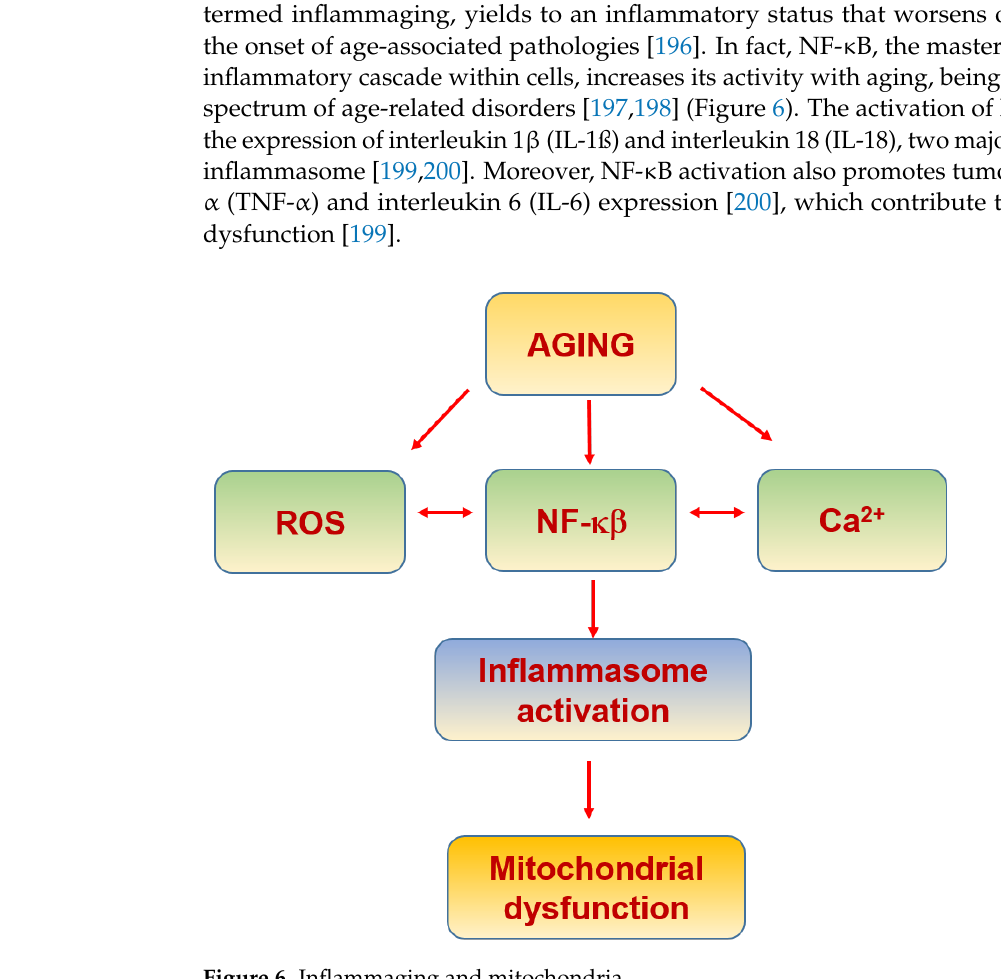
Figure 6. Inflammaging and mitochondria. Inflammasomes are multiprotein signaling patterns responsible for the maturation of pro-IL-1 β and pro-IL-18. Most inflammasomes consist of an upstream sensor, in most cases an adaptor protein (ASC), and inflammatory caspases such as caspase-1. Upon activation, sensor proteins oligomerize with adaptor proteins, forming large complexes called specks (ASC specks) [201]. There is a close relationship between the inflammasome and